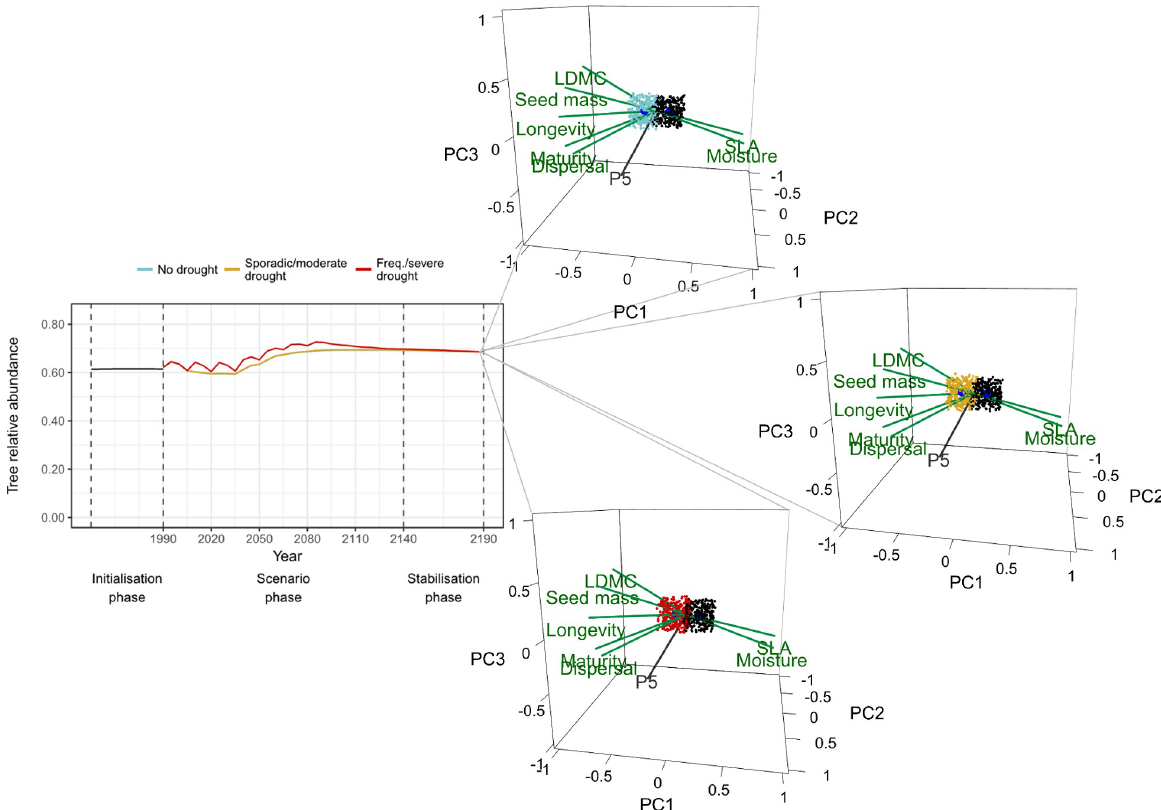
Fig 3. Unmanaged forests. Effects of different drought scenarios on tree transient dynamics and on community states represented by hypervolumes. Current (in black) and future (blue, yellow and red) state hypervolumes are shown with their centroids (in dark blue). Five PFGs with the largest absolute factor loadings on the first three principal components are shown in grey. Functional traits with highest correlations with PC1 (traits with absolute coordinate values � 0.8) are shown in green. Trait vector coordinates were scaled by the corresponding trait vectors’ correlations with ordination axes (only traits with absolute coordinate values � 0.8 on PC1 are shown). For visual clarity, only 300 random sampled points are shown per